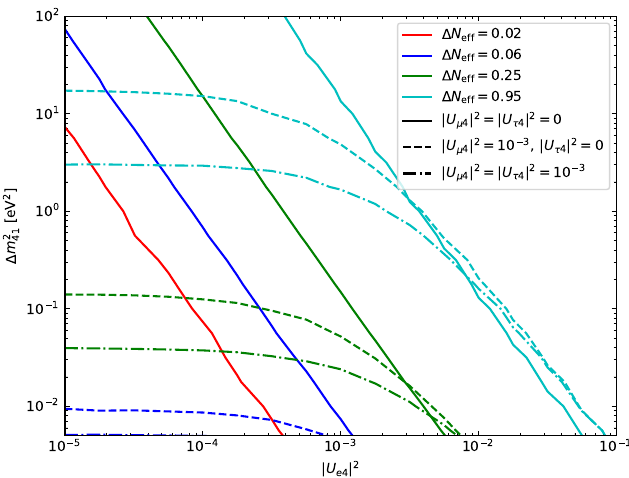
Figure 5. Sterile neutrino contribution ∆ N eff as a function of the active-sterile mixing parameters, for different values of the mixing matrix elements. Colours represent different levels of N eff as follows: ∆ N eff = 0.02 (red, 2 σ future surveys [140,141]), ∆ N eff = 0.06 (blue, 2 σ stage IV CMB and LSS surveys [137]), ∆ N eff = 0.25 (green, 95% CL limit from Planck TT, TE, EE + lowE + lensing + BAO, for m s < 10 eV [95]), and ∆ N eff = 0.95 (i.e., N eff ∼ 4, cyan, practically fully thermalised sterile